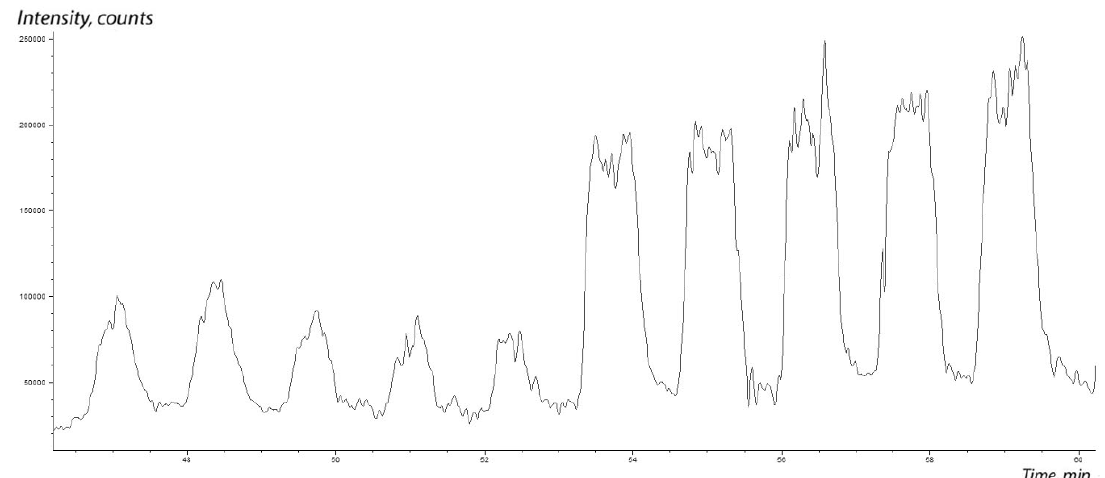
Figure 6. DART-MS chronogram for 5 areas each of 1 and 10 µg of 5-hydroxymethylfurfural recorded with the setup described in Fig. 4 (reproduced from [15], with permission of